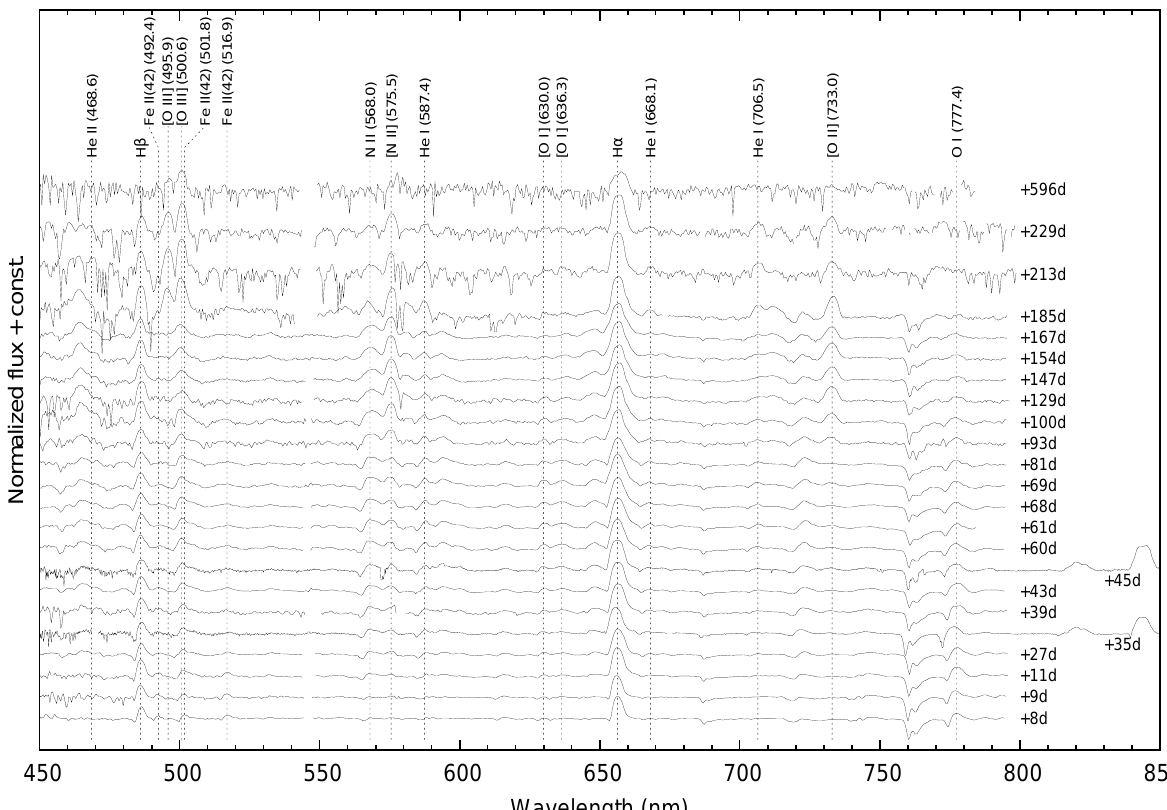
Figure 2: The normalized spectra of V5587 Sgr observed from +8d (= UT 2011 February 2) to +596d (= UT 2012 September 12) after the discovery. These spectra were obtained at Koyama Astronomical Observatory except for the data on +35d and +45d (= UT 2001 March 3 and 12), taken at Higashi-Hiroshima Observatory.